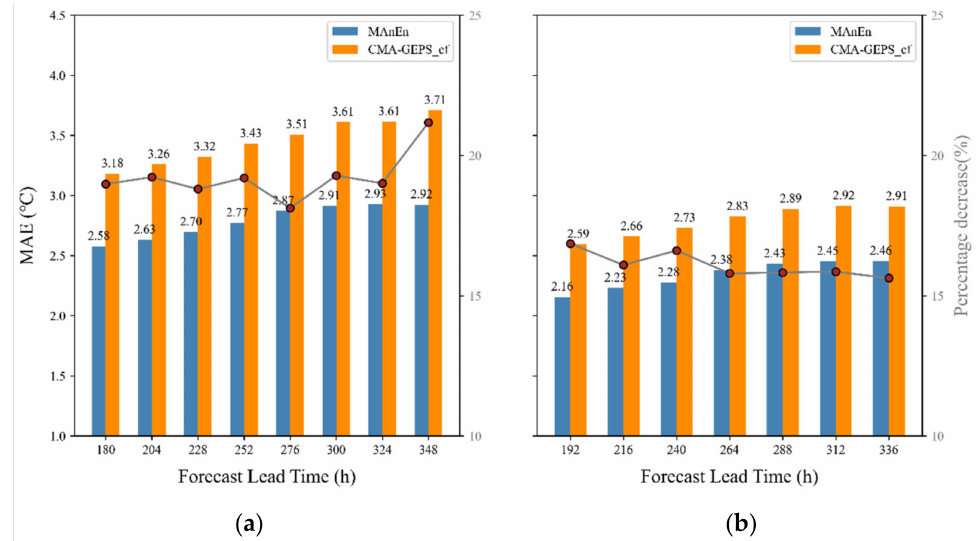
Figure 3. MAE and percentage decrease of analog ensemble averaging forecasts and model forecasts.